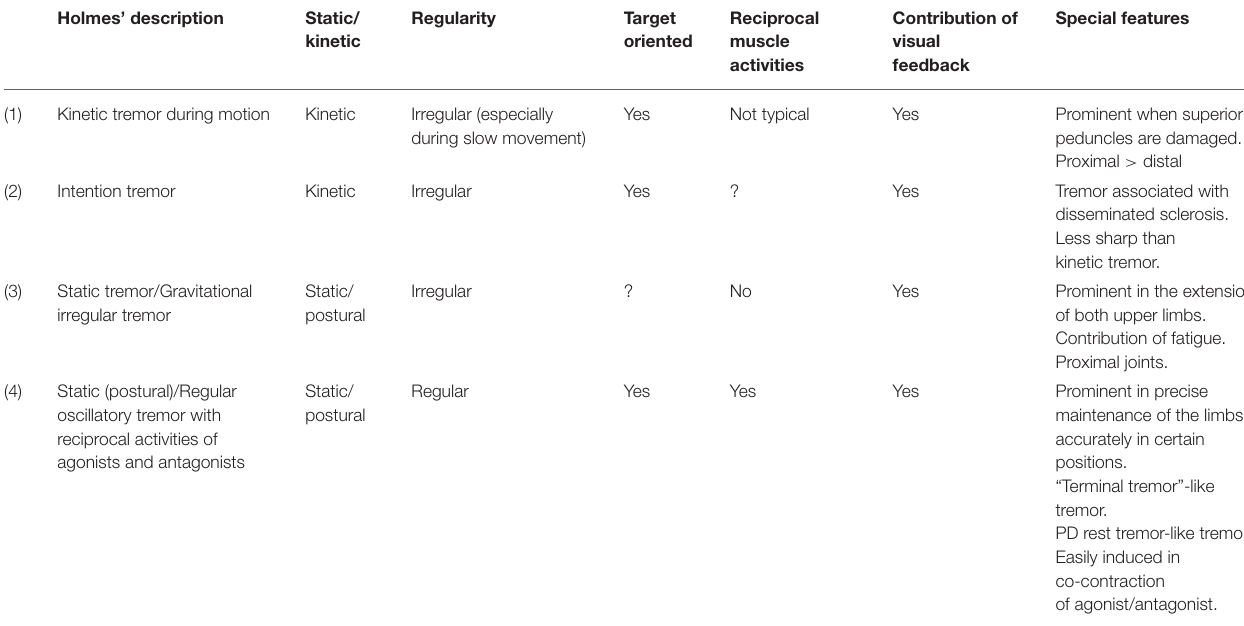
TABLE 1 | Clinical features of various forms of tremors described by Holmes: summary of Holmes’ Croonian lectures given in June